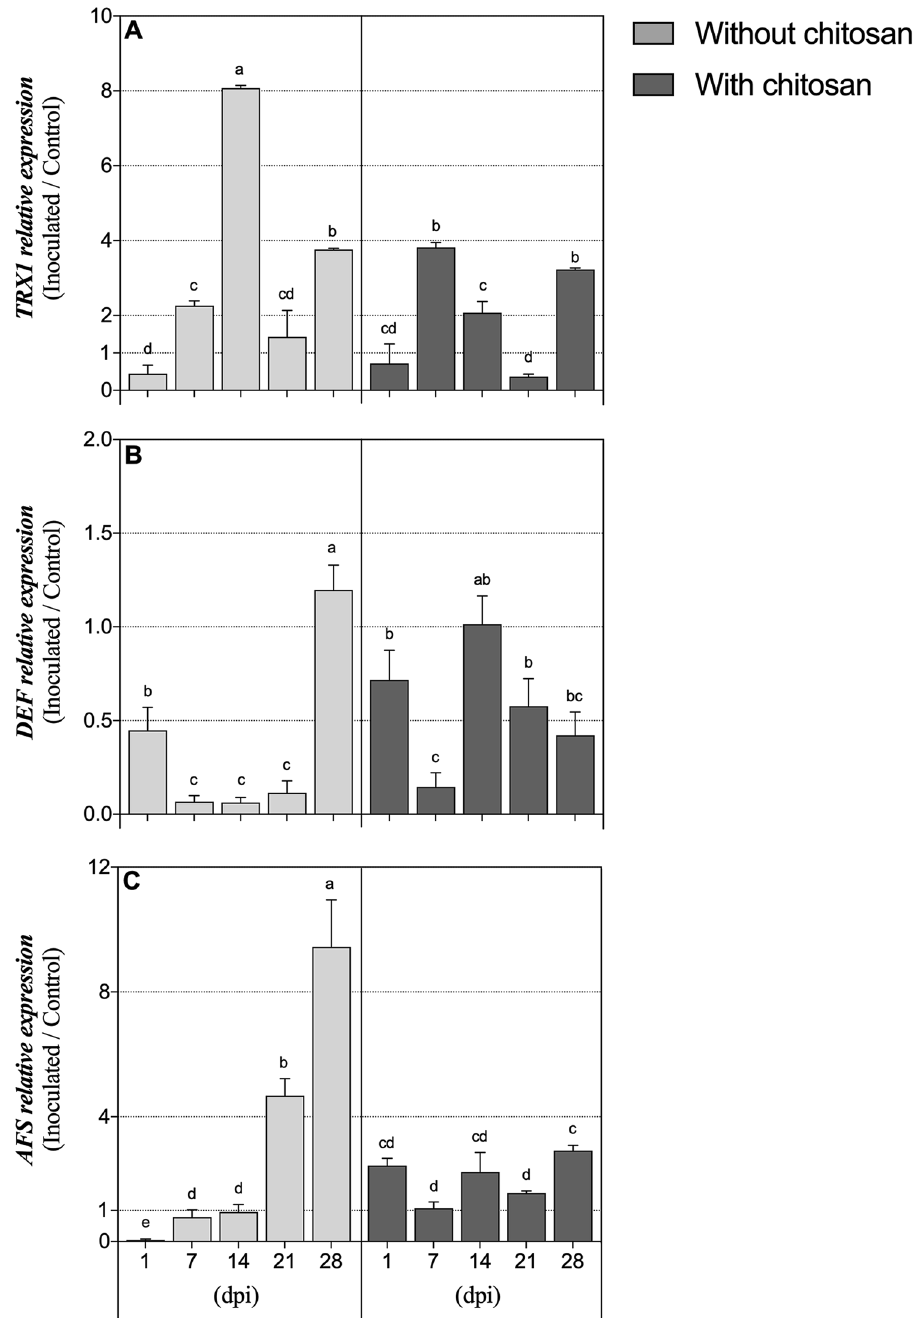
Figure 5. Stress-related gene expression. Fold expression of genes thioredoxin H1(TRX1) ( A ), defensin (DEF) ( B ) and α-farnesene synthase (AFS) ( C ) in plants inoculated with B. xylophilus relative to their expression in water-inoculated plants, 1, 7, 14, 21 and 28 days post-inoculation (dpi). Plants were inoculated 14 days following the application of 0.5% acetic acid (without chitosan, non-elicited controls) or a chitosan solution to plants’ substrate. Data represents the difference between the averages of PWN-inoculated and water-inoculated plants ± SE, and different letters indicate statistically different means at P <